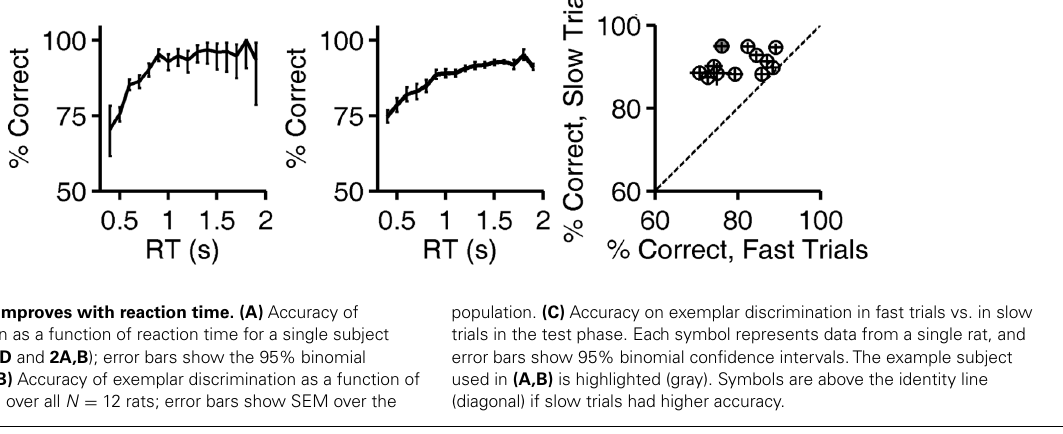
population. (C) Accuracy on exemplar discrimination in fast trials vs. in slow trials in the test phase. Each symbol represents data from a single rat, and error bars show 95% binomial confidence intervals.The example subject used in (A,B) is highlighted (gray). Symbols are above the identity line (diagonal) if slow trials had higher accuracy.